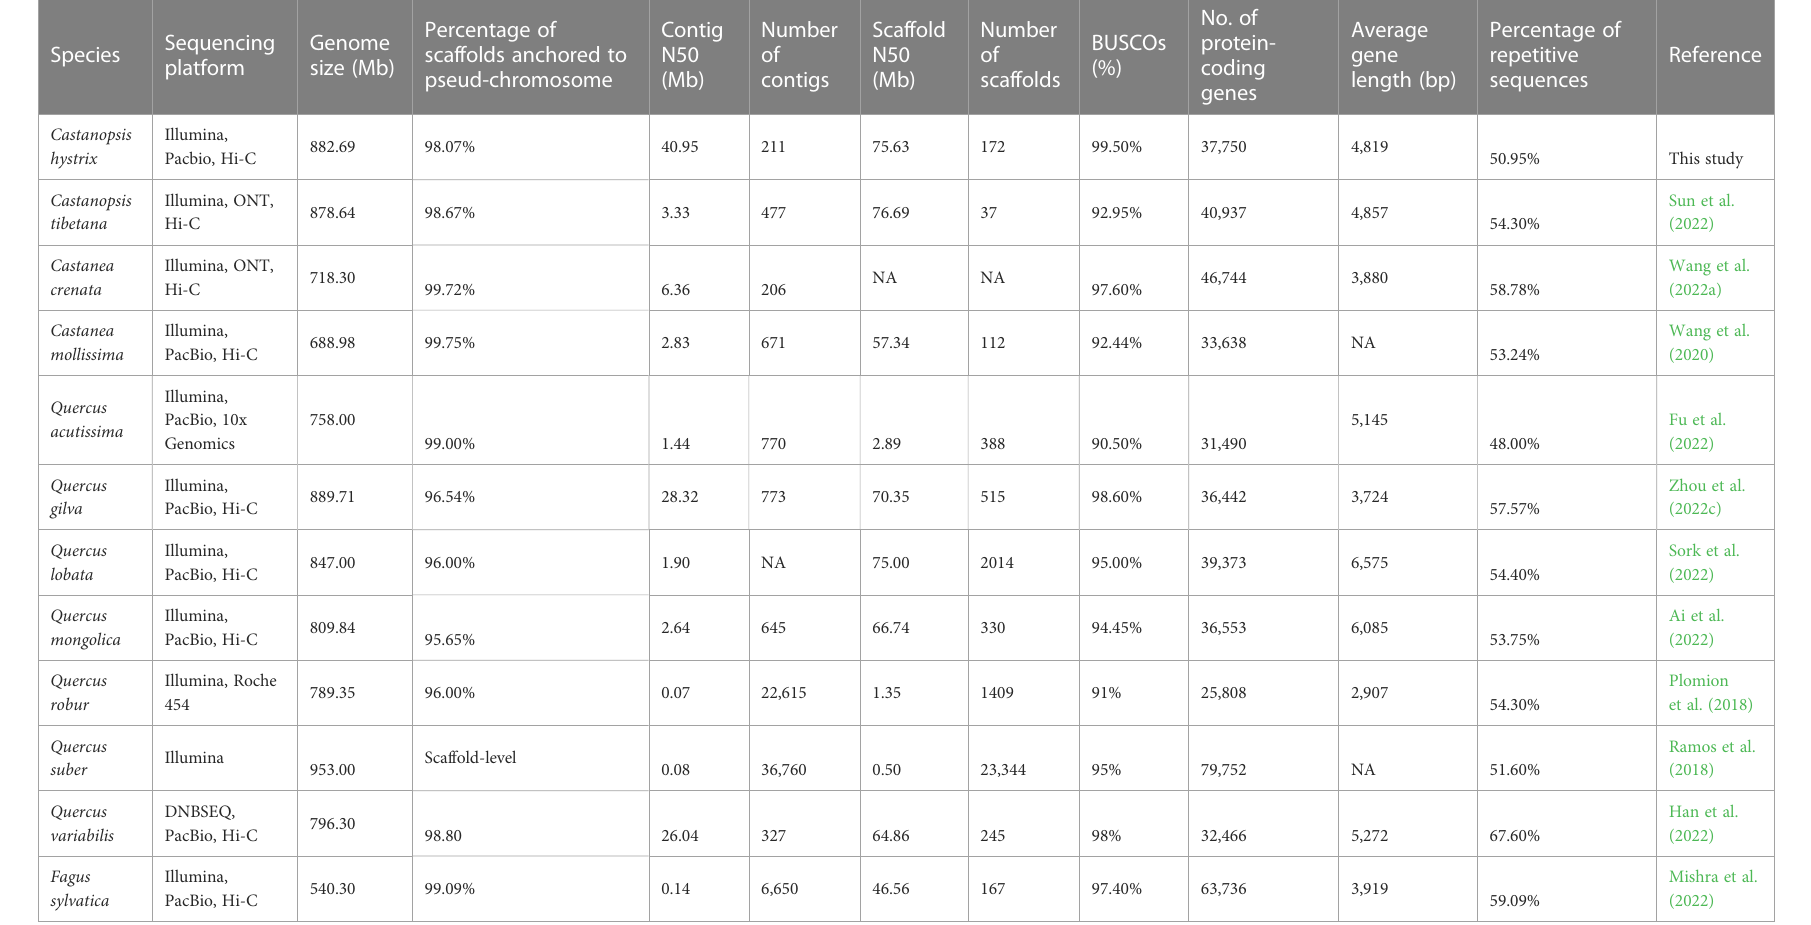
TABLE 1 Comparisons of genome assembly quality among 12 Fagaceae